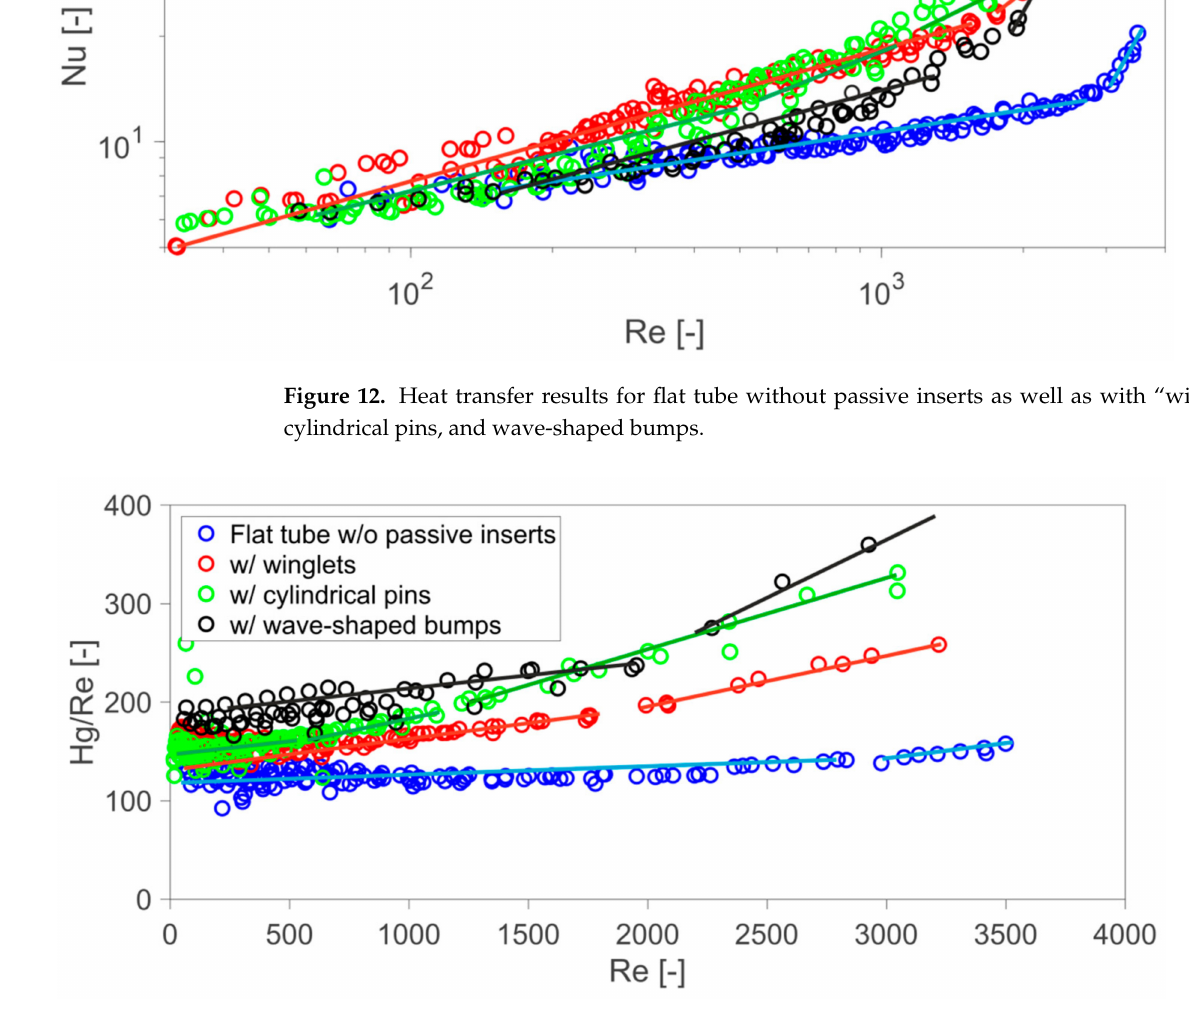
Figure 13. Pressure drop results for flat tube without passive inserts as well as with “winglets”, cylindrical pins, and wave-shaped